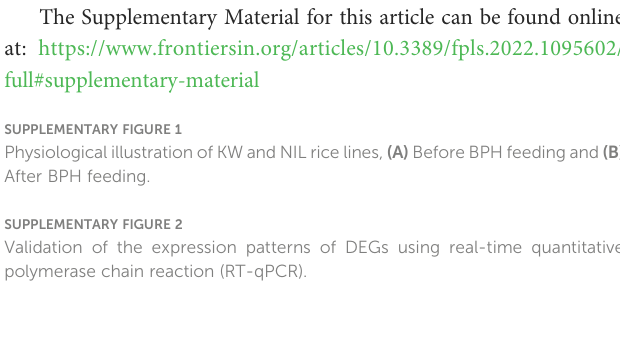
DEGs identi fi ed for KW.